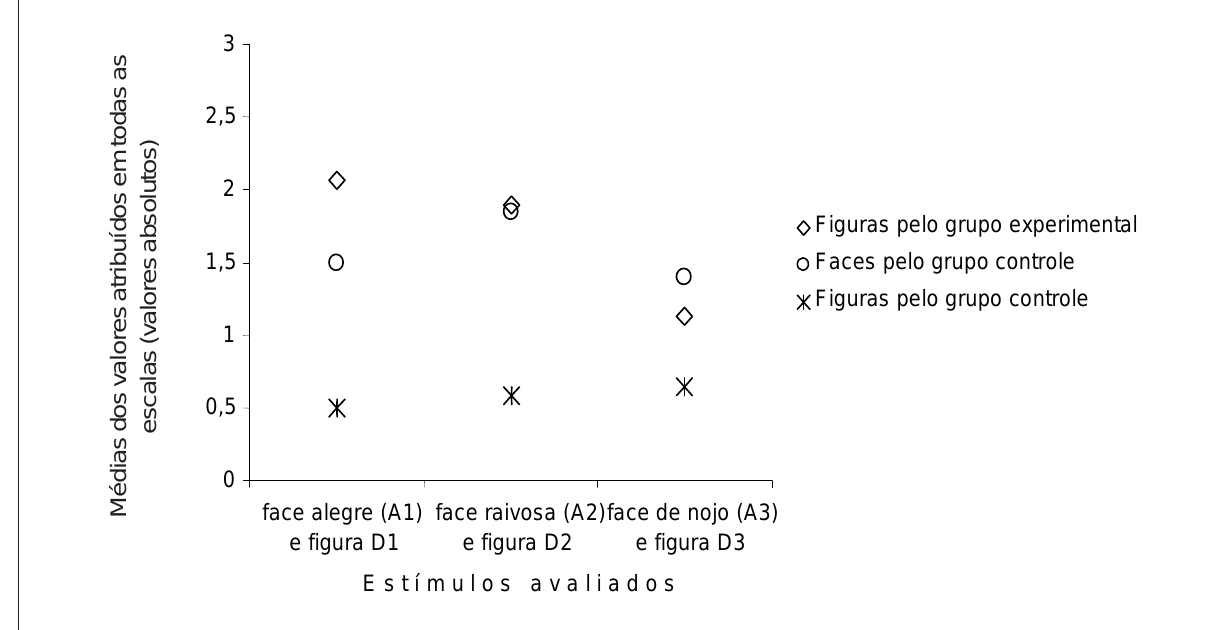
Figuras pelo grupo experimental Faces pelo grupo controle